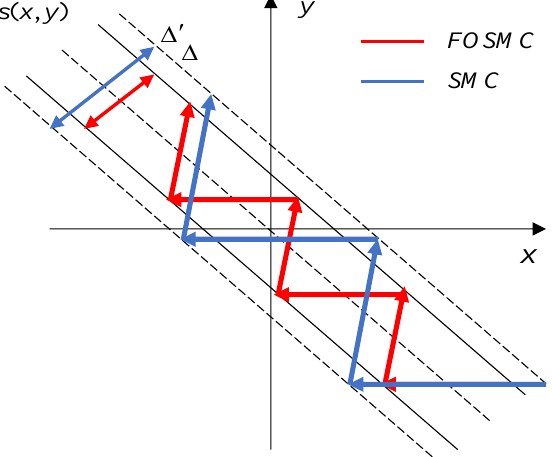
Figure 2. System properties under the FOSMC and SMC.